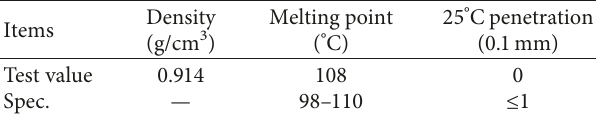
Table 2: Physical properties of RH.